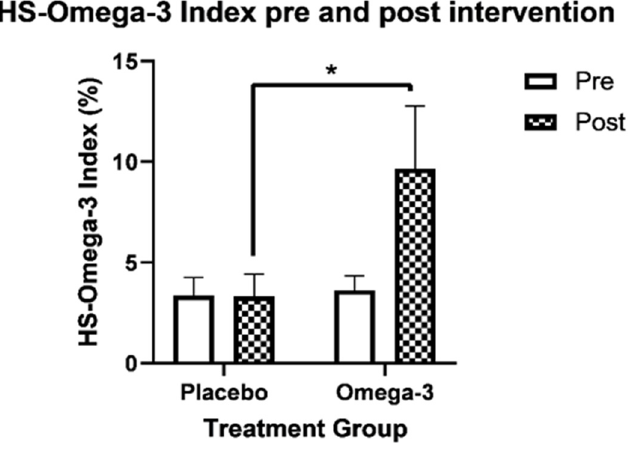
Figure 2. Change in HS-Omega-3 Index ® per treatment group, * denotes a significant difference between treatment groups at post-intervention, p < 0.001.